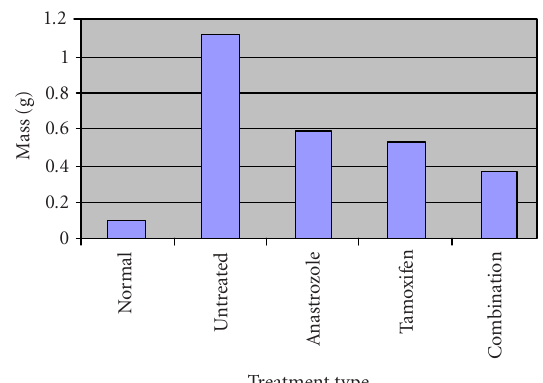
Figure 2. Spleen masses of female BALB/c mice on day 28 of the experiment. All mice except the normal (negative control) were inoculated with 4T1 cells 28 days prior to spleen removal and treated with either PBS, anastrozole, tamoxifen, or the combi-